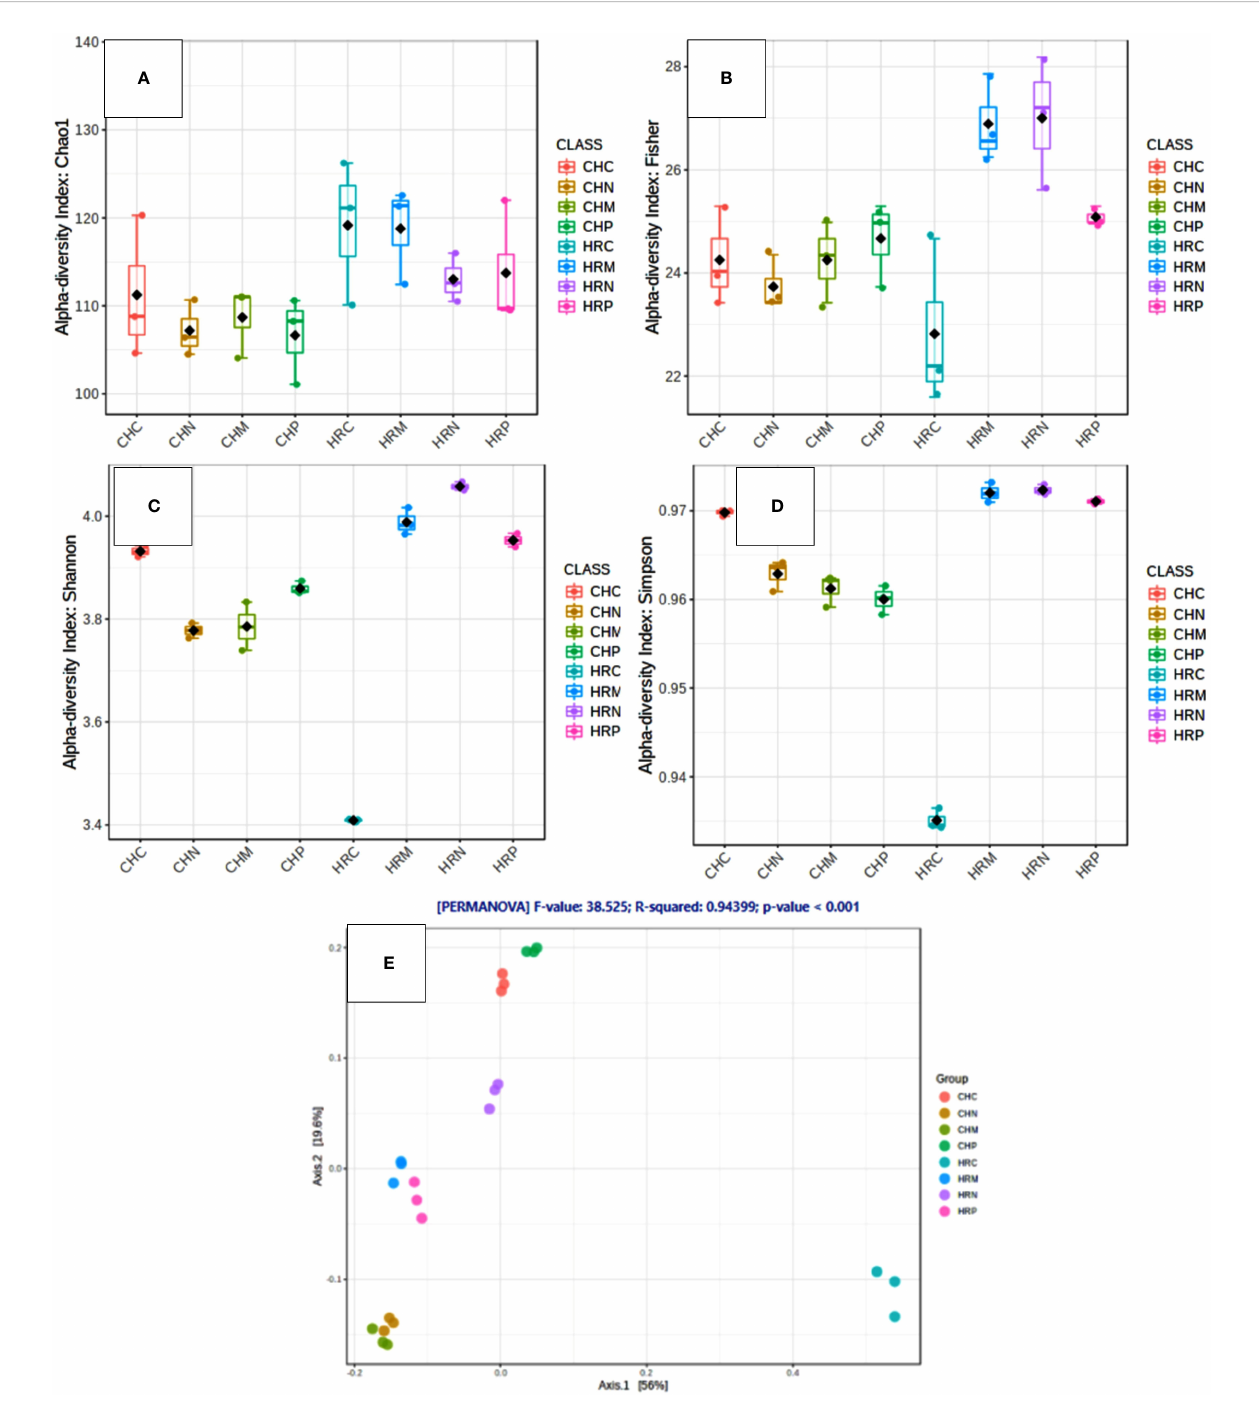
FIGURE 4 Diversity analysis within and among the samples through various indices. (A – D) Alpha Diversity through (A) Chao1 (B) Fischer (C) Shannon (D) Simpson and beta diversity through (E) principal coordinate